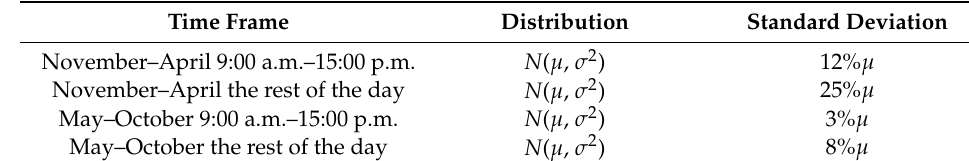
Table 3. Probabilistic distributions of hourly PV power. Time Frame Distribution Standard Deviation